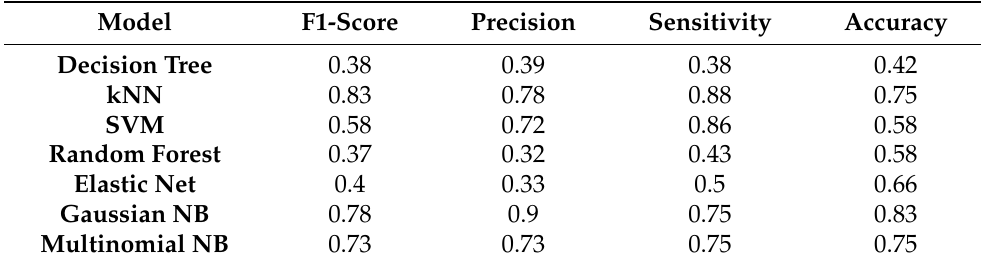
Table 2. Metrics from classification models for PPA vs. CG.